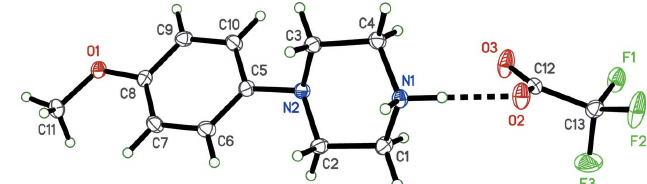
Figure 1 An ellipsoid plot (50% probability) of I . The dashed line denotes an N— H (cid:2)(cid:2)(cid:2) O hydrogen bond. Hydrogen atoms are drawn as arbitrary circles.